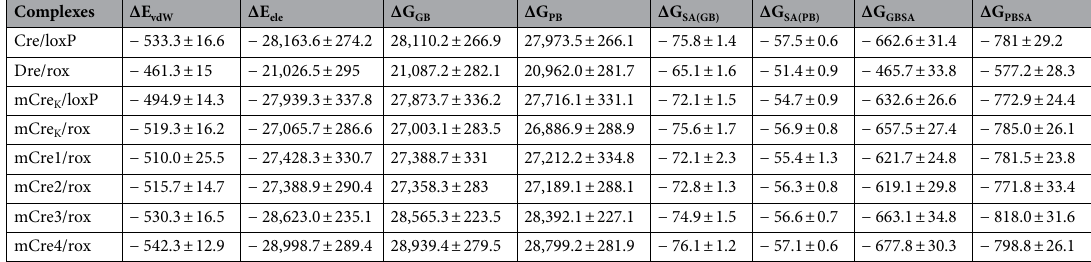
Table 1. Calculated MM-GB/PBSA binding energies and corresponding standard deviations (kcal/mol) for the studied SSRs complexes. ΔE vdW van der Waals energy, ΔE ele columbic energy, ΔG GB Generalized-Born polar